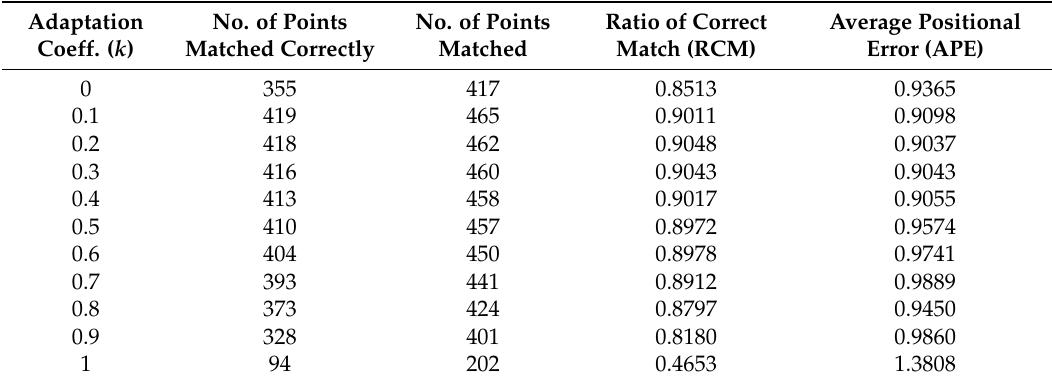
Table 4. Performances and results of map-matching for Trajectory 1 depending on the adaptation coefficient k .